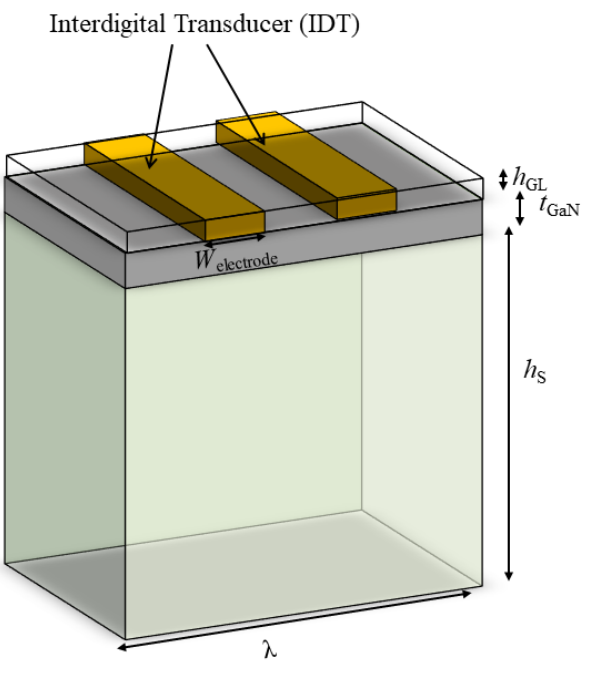
Figure 3. Schematic diagram of the 3D model of a unit cell of a GaN/sapphire device used in the FEM simulation